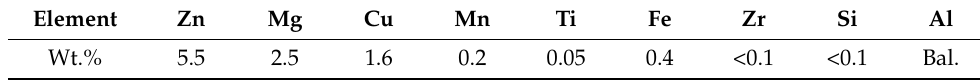
Figure 1. Schematic diagram of the CWJP process. ( a ) CWJP device; ( b ) scanning position and peening area; ( c ) surface of the specimen after the CWJP treatment. Table 1. Chemical composition of